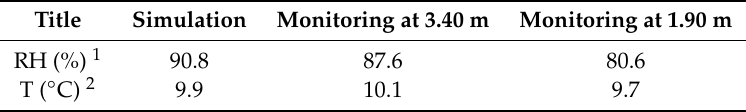
Table 3. Synthesis of the averaged hygrothermal